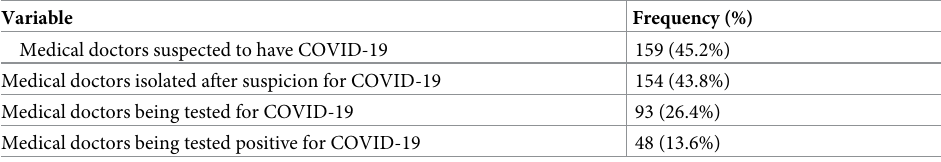
colleagues in 37.5% (n = 18) of respondents, followed by patients (20.8%, n = 10). (P < 0.04) (Fig 1). Factors associated with exposure risk to COVID-19 The study showed a statistically significant gender difference (74% (n = 134) of males had higher exposure risk to COVID-19 infection compared to 64% (n = 110) of females) in risk of exposure to COVID-19 infection; OR = 0.5, 95% CI 0.4–0.9), p < 0.02. On the contrary, Expo- sure risk was not affected by age (OR = 0.9, 95% CI 0.9–1.0), p > 0.55). Doctors working in ER had higher exposure to the infection compared to other work settings (p < 0.03) (Table 3). Similarly, almost three-quarters of doctors who received training on COVID-19 had a high Table 2. Proportion of doctors, who have been suspected, isolated, tested, or have positive results and the source of infection. Variable